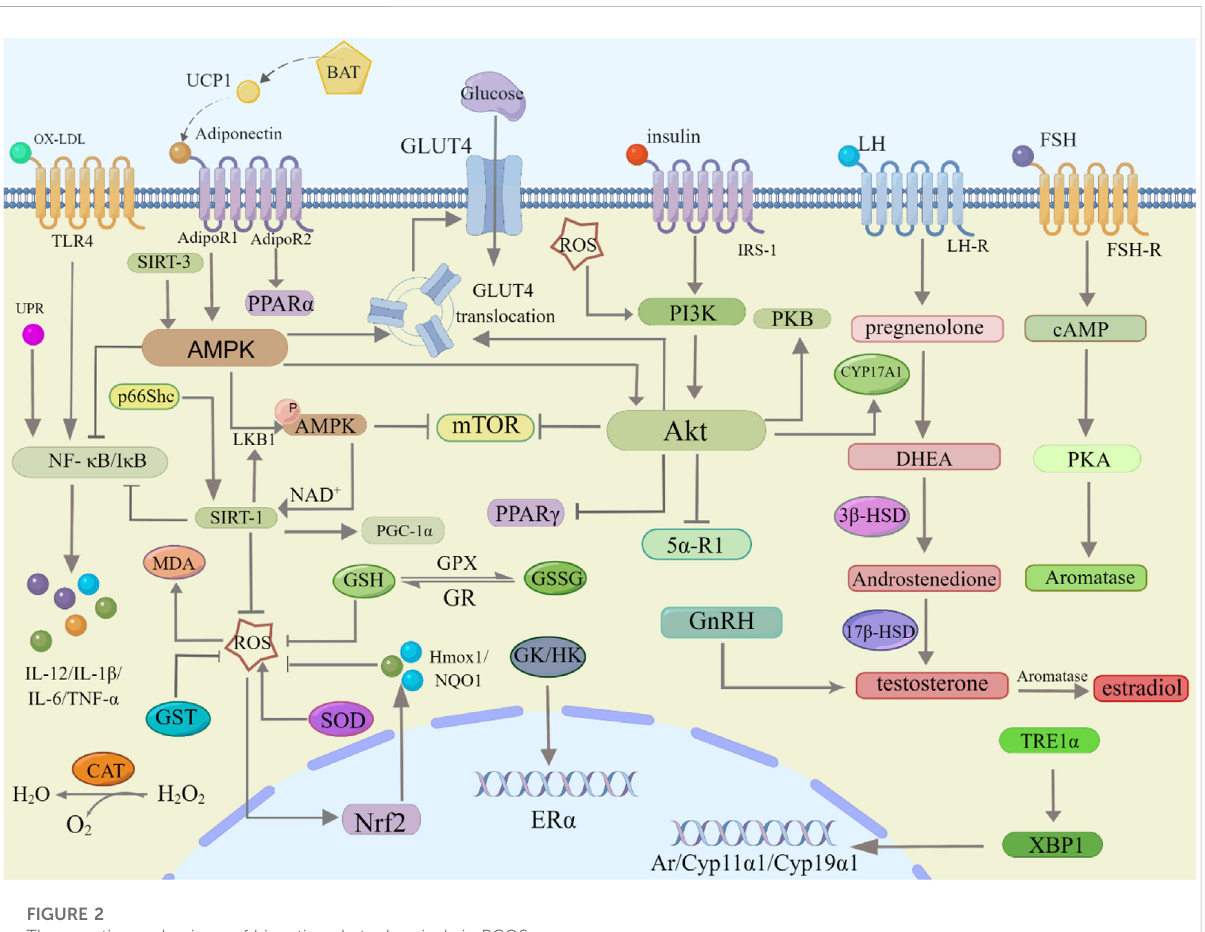
Therapeutic mechanisms of bioactive phytochemicals in